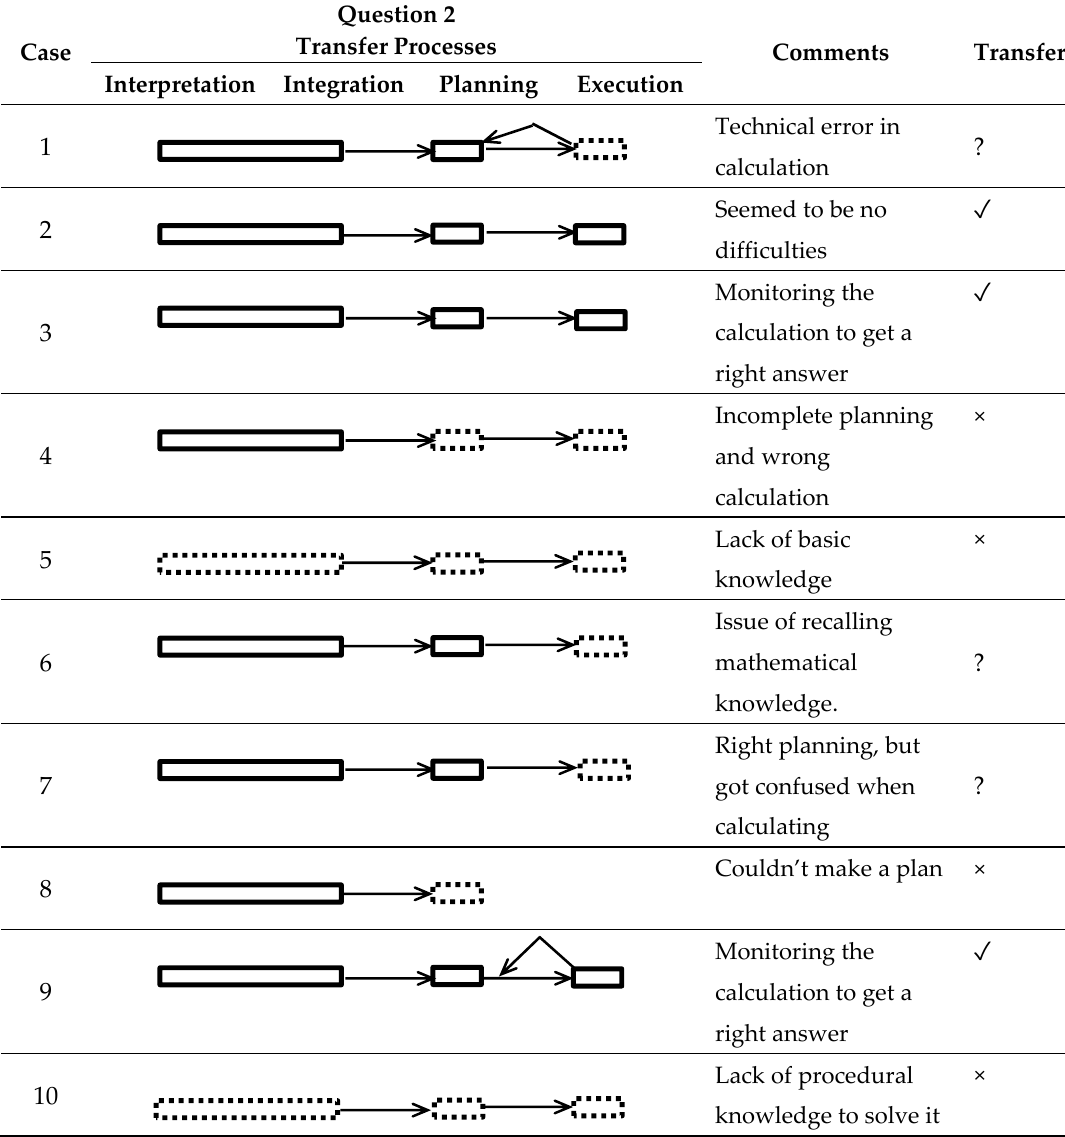
Figure 3. ( a ) Think-aloud reports on transfer processes for question 1. ( b ) Think-aloud reports on transfer processes for question